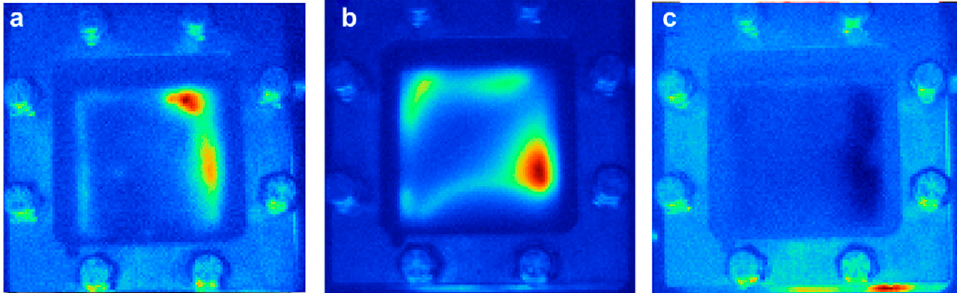
Figure 7. IR images of CCMs after 500 h OCV hold test: ( a ) Baseline, ( b ) synthesized 1.0 wt. % h and ( c ) commercial ceria 1.0 wt. % (red areas show higher temperature caused by reaction of hydrogen and air due to hydrogen crossover) [68].